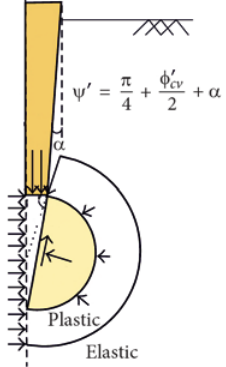
fig. 3. Pattern of modified failure mechanism around the tapered pile tip in cavity expansion